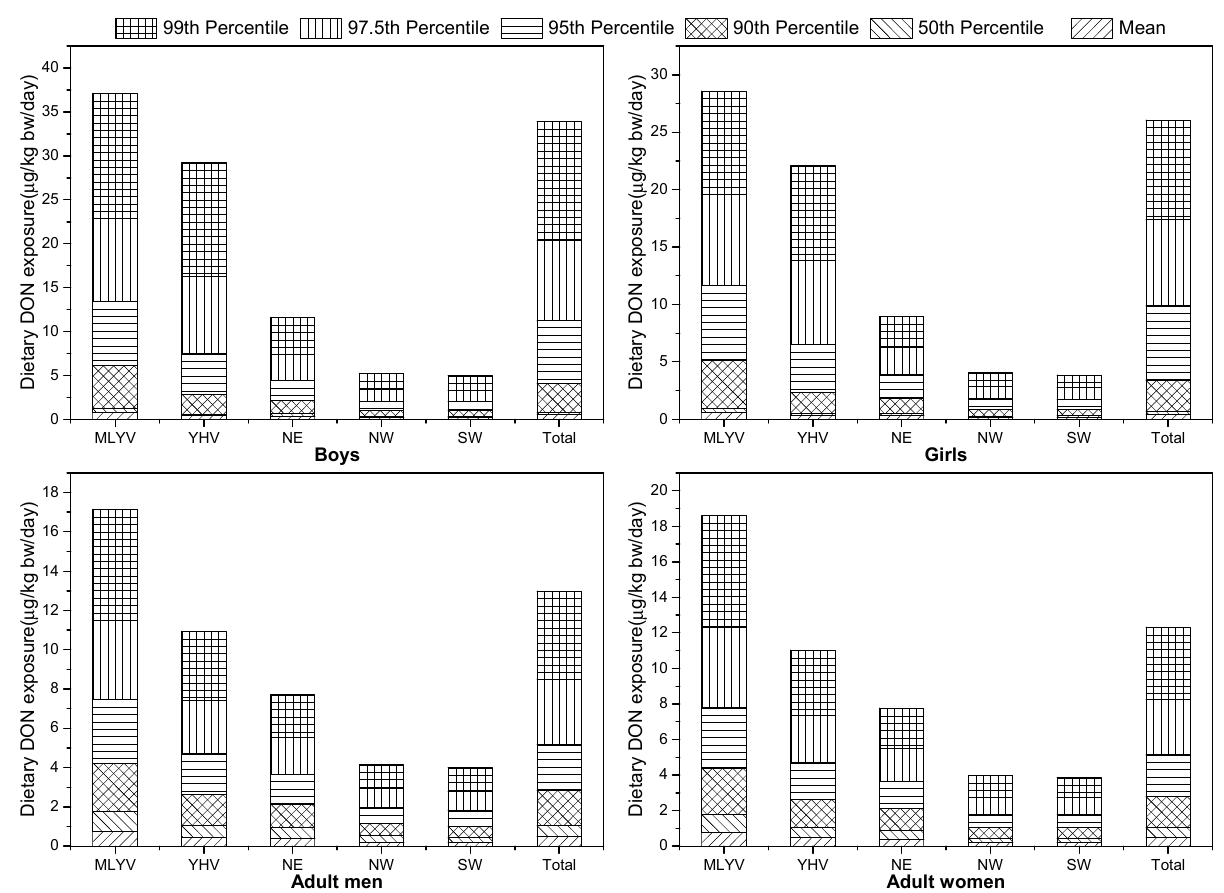
Figure 3. The estimated dietary DON exposure through wheat-based products from different production areas for 7- to 10-year-old children and adults determined by probabilistic evaluation.